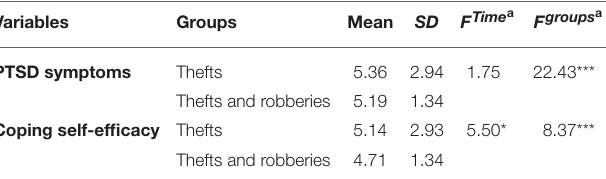
TABLE 5 | ANCOVA results for PTSD symptoms and coping sel-efficacy among affected groups. Variables